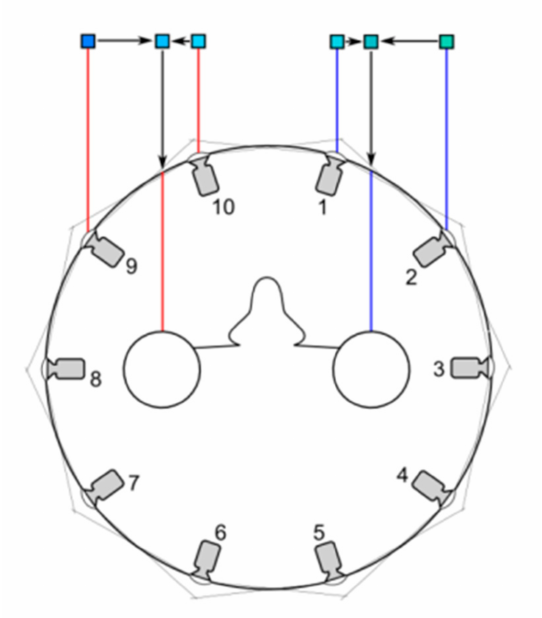
Figure 4. The stereoscopic vision of left and right eyes.